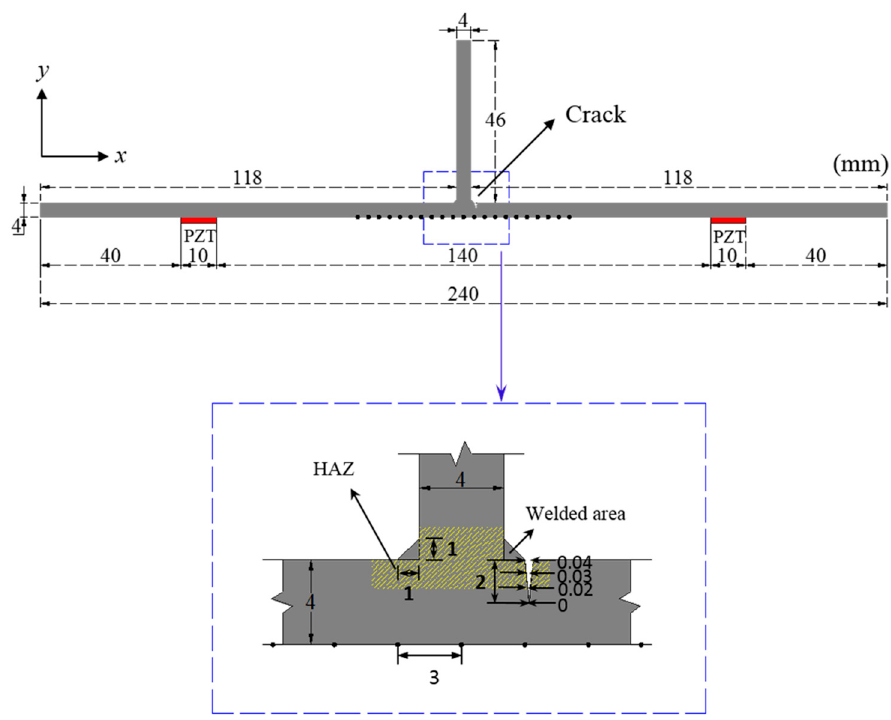
Figure 4. 2D plane strain model with a vertical stiffener: The PZTs with a dimension of 10 × 0.508 mm 2 are modeled on the opposite surface to the vertical stiffener for Lamb wave generation. The depth of the crack is 2 mm and its width is varying from 0 to 40 μ m along the through-the-thickness direction at HAZ.